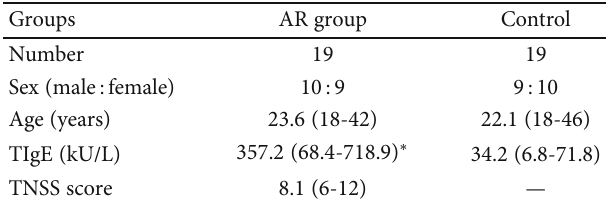
Table 1: Demographic characteristic of AR patients and normal